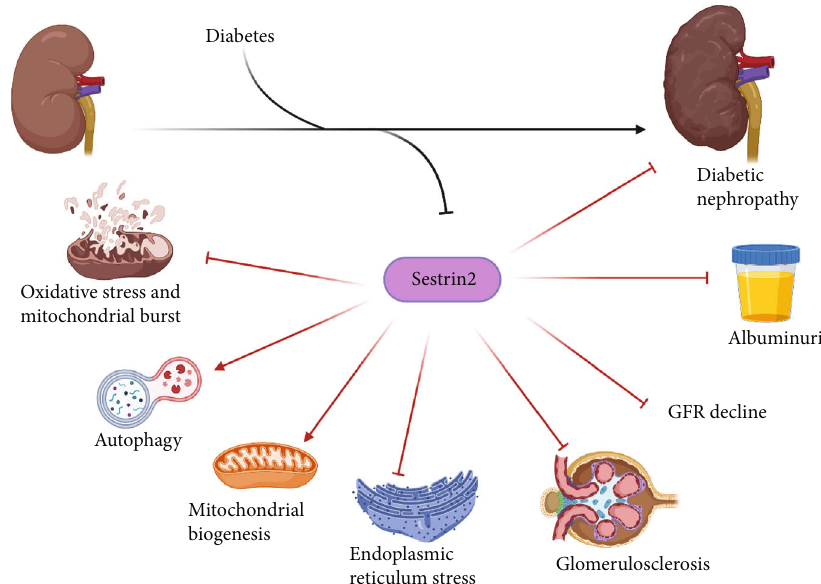
Figure 3: The involvement of Sestrin2 in diabetic nephropathy. Diabetes and hyperglycemia downregulate Sestrin2 expression in the kidney. Patients and animals with diabetic nephropathy have decreased expression of Sestrin2 in their kidneys which is associated with progression of albuminuria and GFR decline. Sestrin2, an antioxidant and a metabolic regular, enhances autophagy and mitochondrial biogenesis and attenuates oxidative stress and endoplasmic reticulum stress. Furthermore, Sestrin2 prevents fi brogenesis. It has been observed that upregulation of Sestrin2 can suppress in fl ammation, oxidative stress, and renal fi brosis in animal models of diabetic nephropathy and decelerate the progression of albuminuria and GFR